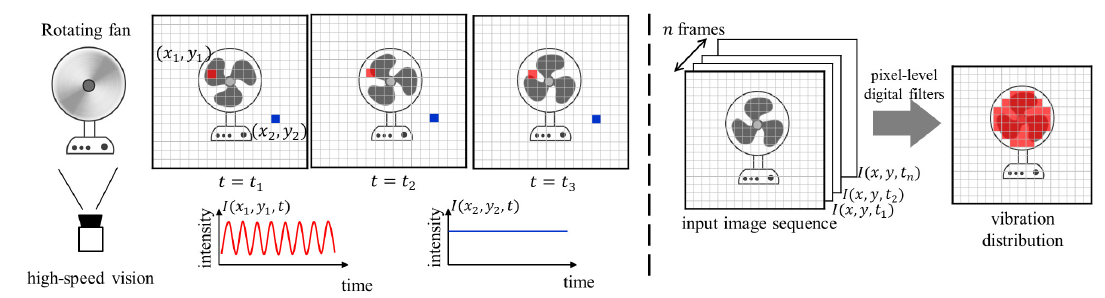
Figure 1. Concept of vibration features with pixel-level digital